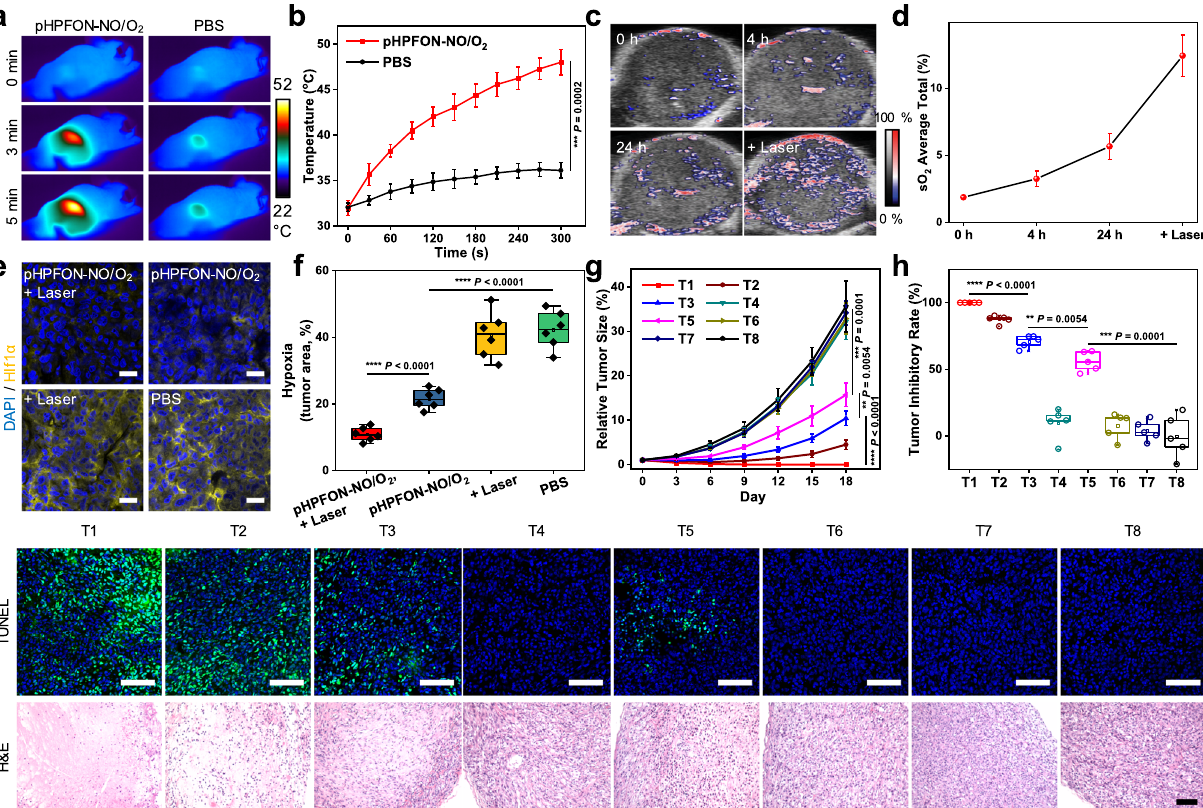
Fig. 7 Therapy studies of pHPFON-NO/O 2 in a U87MG tumor model. a Thermographic images of pHPFON-NO/O 2 or PBS-treated mice upon laser irradiation (808 nm, 1 W/cm 2 ) at 24 h p.i. at the tumor sites. n = 3 biologically independent animals. b Plots of tumor temperature with irradiation duration based on a . c PA imaging of tumor oxygenation change after pHPFON-NO/O 2 injection and a following laser irradiation at 24 h p.i. n = 3 biologically independent animals. d Quanti fi cation of oxygen saturation level according to c . e Anti-HIF-1 α staining on tumors after different treatments. Laser was applied at 24 h p.i. Experiments were performed three times with similar results. Blue, DAPI; yellow, HIF-1 α . Scale bar, 20 μ m. f Quantitative tumoral hypoxia evaluation ( n = 6 independent experiments) according to the results in e . g Tumor growth curves, h tumor inhibitory rates, and i tumor histological analysis with TUNEL (green, TUNEL; blue, DAPI.) and H&E staining assays after different treatments. n = 5 biologically independent animals with similar results. Scale bar, 100 µ m. For g – i , groups T1 – T8: T1, pHPFON-NO/O 2 + 5-min laser + X-ray; T2, pHPFON-NO/O 2 + 5-min laser; T3, pHPFON-NO/O 2